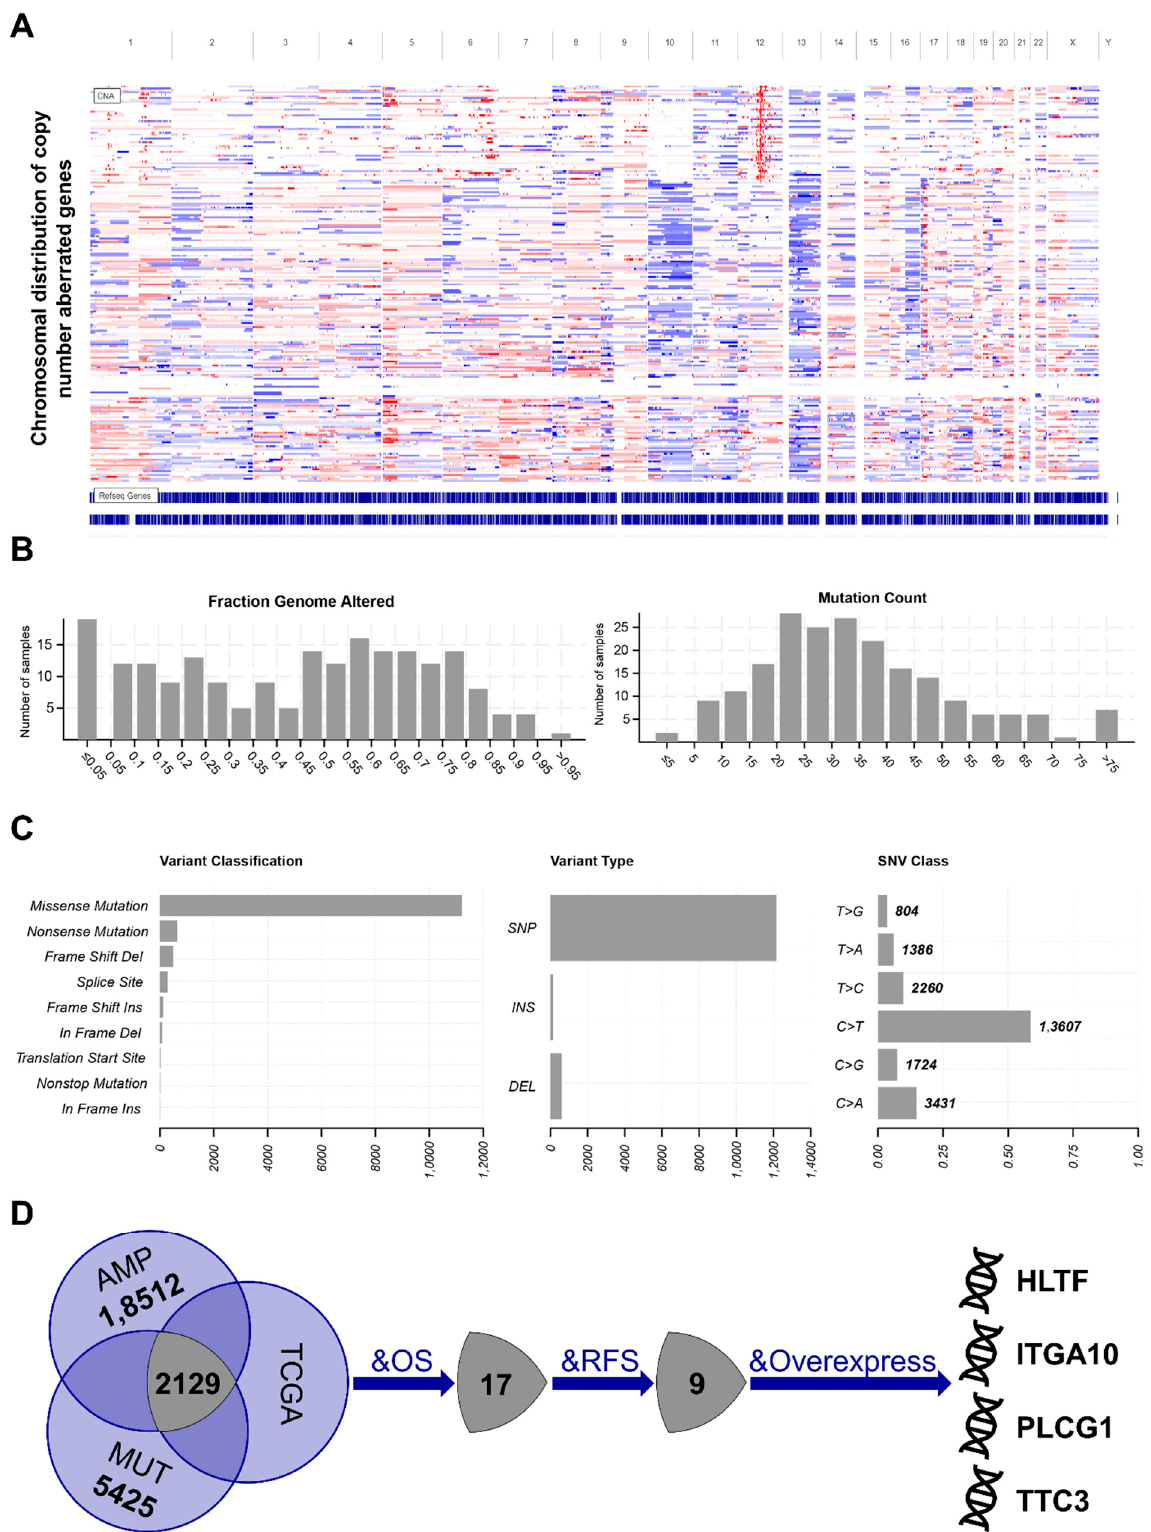
Figure 1. Identification of potential tumor antigens in STS. ( A ) The chromosomal distribution of the gene copy number aberrations in STS. ( B ) Samples in altered genome fraction and mutation count groups. ( C ) Summary of the mutation information for STS. ( D ) The intersection of amplified (AMP: 18,512) and mutated (MUT: 5425) genes, of which 2129 were detected in TCGA. In total, four of these potential tumor antigens were significantly associated with OS and RFS prognosis and were